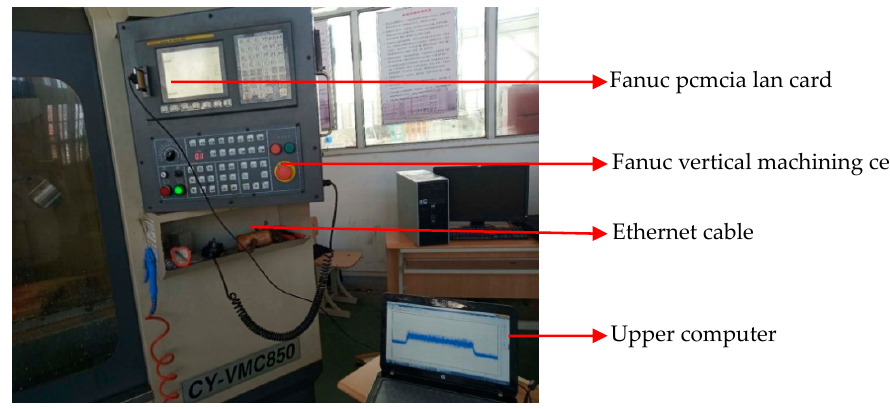
Figure 2. Current signal acquisition diagram.